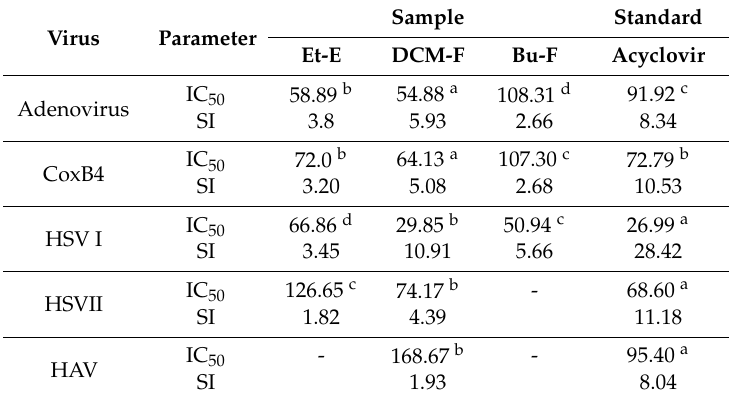
Table 2. IC 50 ( µ g / mL) and selectivity index (SI) of Hibiscus schizopetalus by protocol